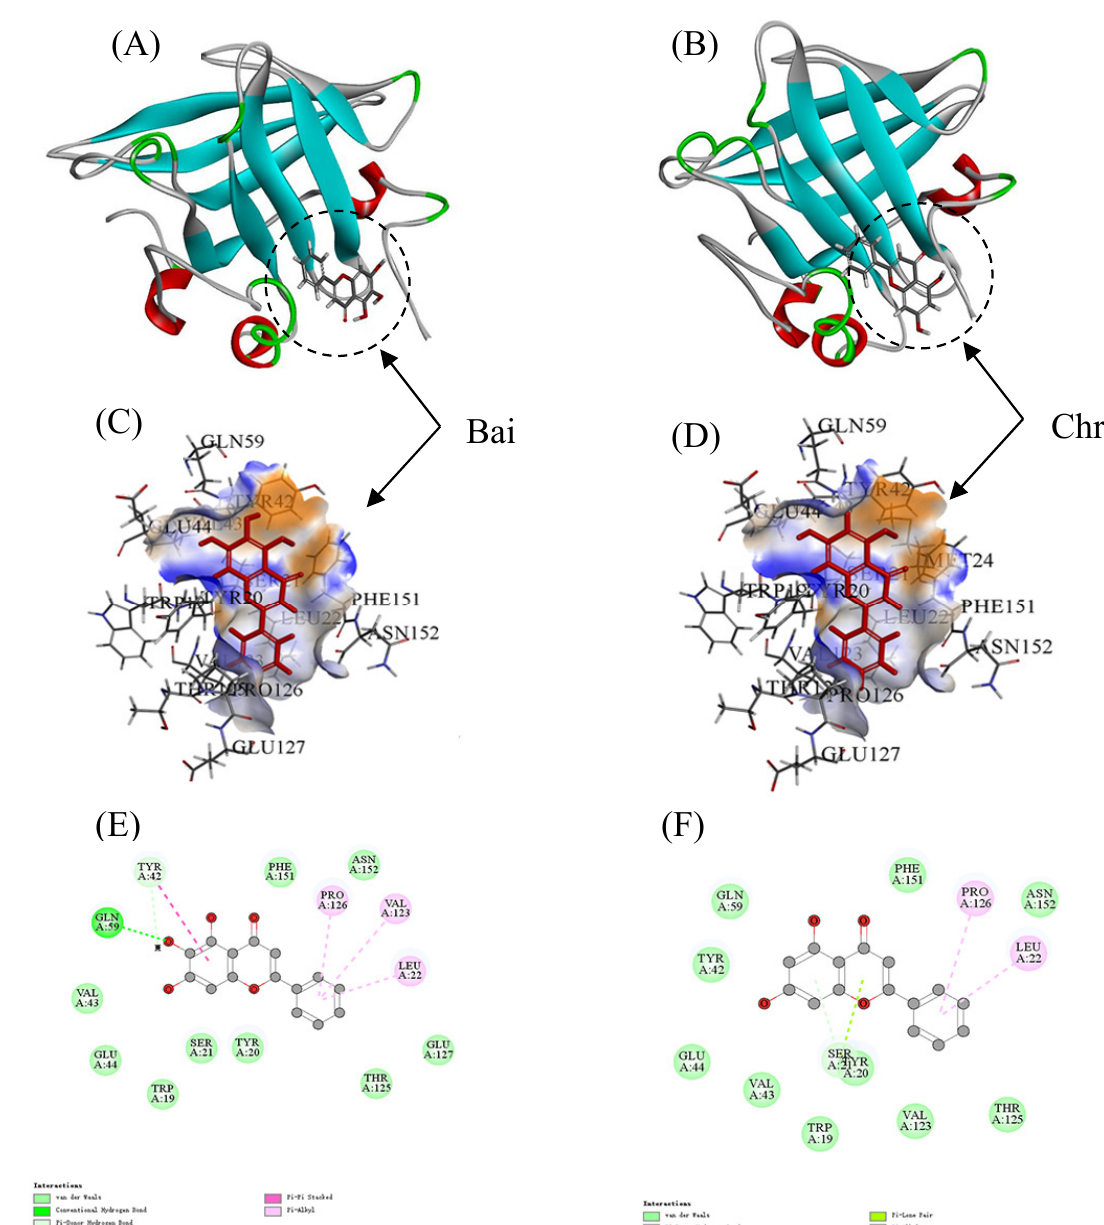
Figure 5. Docking results between flavonoid (Bai or Chr) and BLG by LibDock of Discovery Studio. 2D and 3D diagrams of Bai ( A , C , E ) and Chr ( B , D , F ) interacting with BLG.